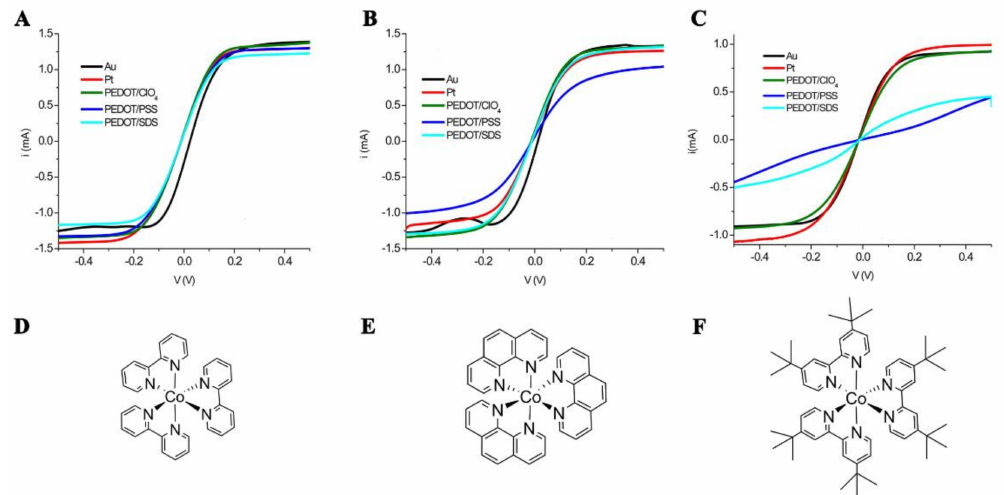
Figure 6. IV curves in symmetric dummy cells containing cobalt-based electron-transfer mediators: ( A , D ) [Co(bpy) 3 ] 3+/2+ , ( B , E ) [Co(phen) 3 ] 3+/2+ , ( C , F ) [Co(dtb) 3 ] 3+/2+ . Adapted with permission from Ref [17]. Copyright 2013 American Chemi- cal Society.